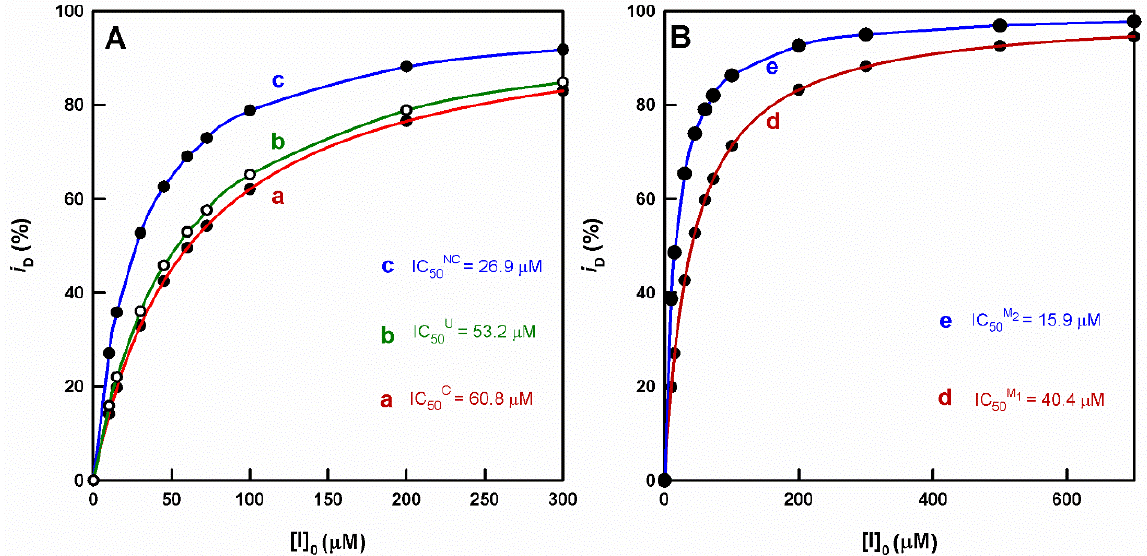
Figure 7. ( A , B ). Representation of the degrees of inhibition i D obtained for each type of reversible and fast inhibition giving a hyperbolic behavior, against the inhibitor concentration. ( A ) a, competitive; b, uncompetitive; c, non-competitive. ( B ) d, mixed type (1) and e, mixed type (2). Con- ditions: a. Competitive: [E] 0 = 10 × 10 −9 M , [E ox ] 0 = 0.3 × [E] 0 , [E m ] 0 = 0.7 × [E] 0 ; [D] 0 = 0.5 ×